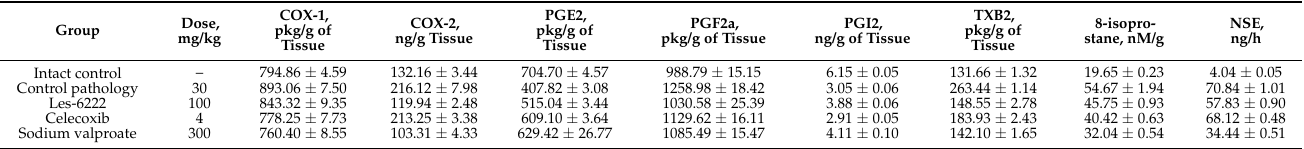
Table 2. Effects of Les-6222, sodium valproate, and Celecoxib on the cyclooxygenase pathway of the arachidonic acid cascade, 8-isoprostane and NSE on the pentylenethazole kindling model in mice, M ±